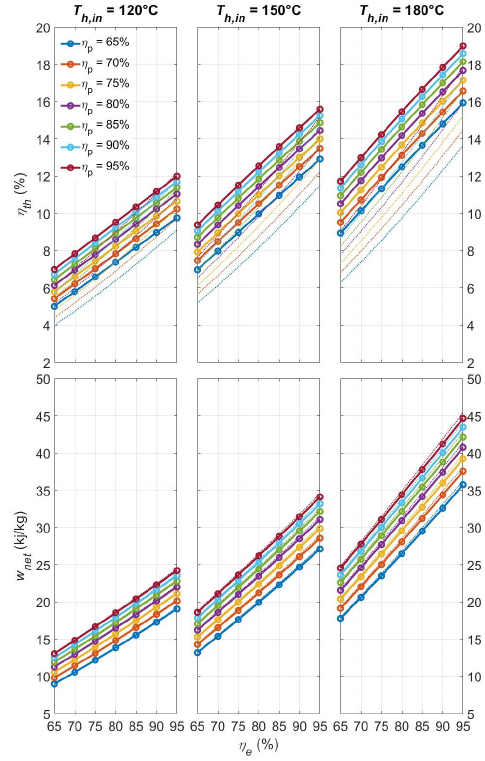
Figure 11. η th and w net of the recuperative cycle at the design point under different circumstances of η p , η e , and T h , in (the dotted lines represent the values of the simple cycle in Figure 6).